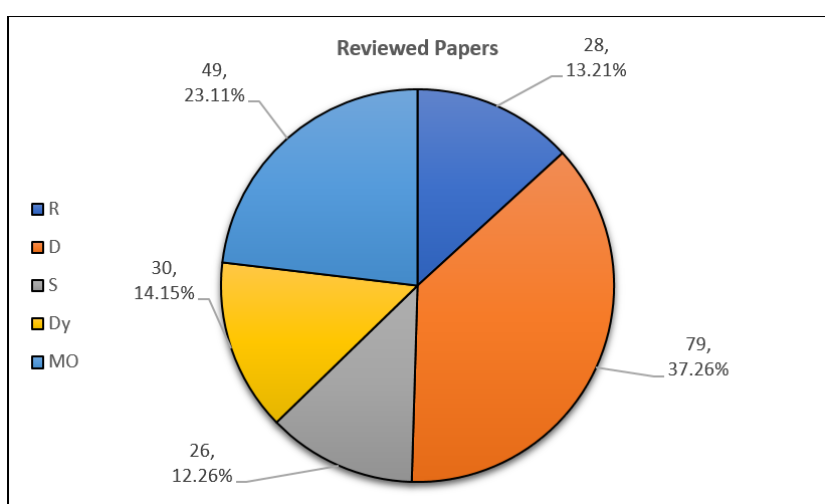
Figure 17. Breakdown of Reviewed Papers based on Model